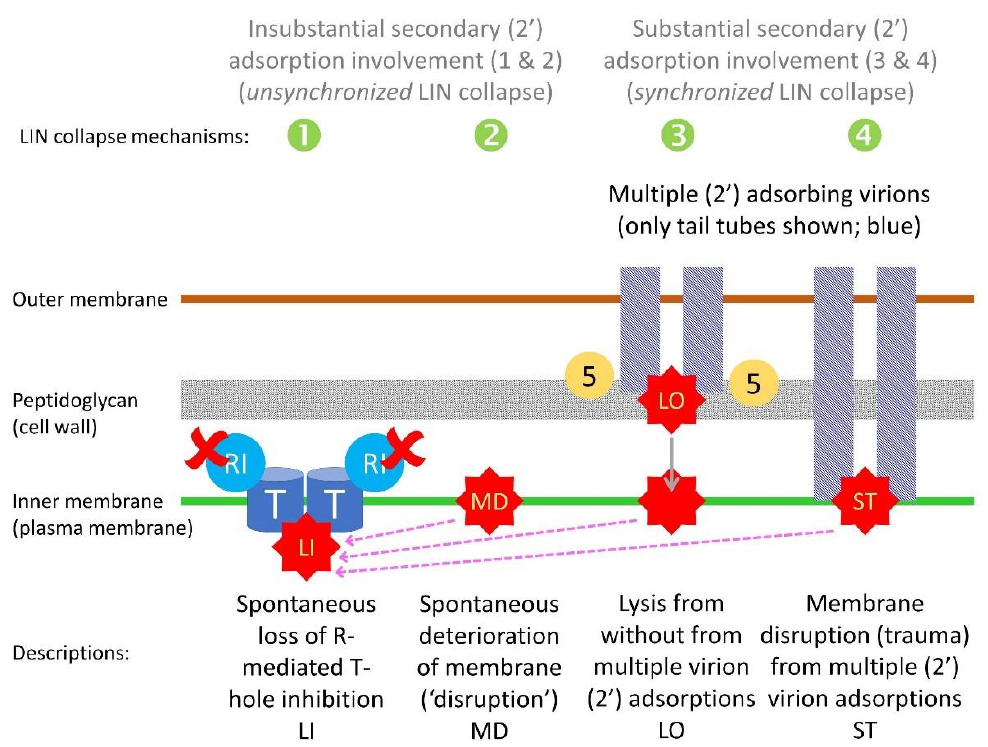
Figure 8. Possible mechanisms leading to lysis-inhibition collapse. Loss of R-mediated inhibition of T-hole formation is indicated with the marks, resulting in lysis from within (LI). Note that protein RIII is not illustrated in the figure for the sake of reducing clutter. Membrane deterioration (MD) results in a spontaneous loss of plasma membrane function as a chemiosmotic barrier, likely leading to LI (top dashed arrow as leading to mechanism 1). Lysis from without as caused by the gene 5 lysozyme product, which is associated with T4 virions, can result from multiple virion secondary (2′) adsorptions. The associated cell-wall disruption gives rise to plasma membrane disruption (as indicated by the vertical, gray arrow), thereby presumably leading LINed bacterial infections also to LI (middle dashed arrow). Perhaps independent of LO is possible membrane disruption also caused by excessive phage secondary adsorptions, giving rise to what can be described as a secondary traumatization (ST), with disruption of the plasma membrane chemiosmotic barrier again potentially resulting in LI (lower dashed arrow). The R-mediated inhibition of LI, as would be overcome for mechanism 1, is discussed in Section 5.2. Section 5.3.2 discusses evidence against the significance of mechanism 2 to LIN collapse. Mechanism 3 likely is inhibited to some degree by gene sp expression by primary phages (Section 5.4, but not illustrated in the figure). Mechanism 4 possibly is inhibited to some degree by gene imm expression (also Section 5.4, and also not illustrated in the figure).